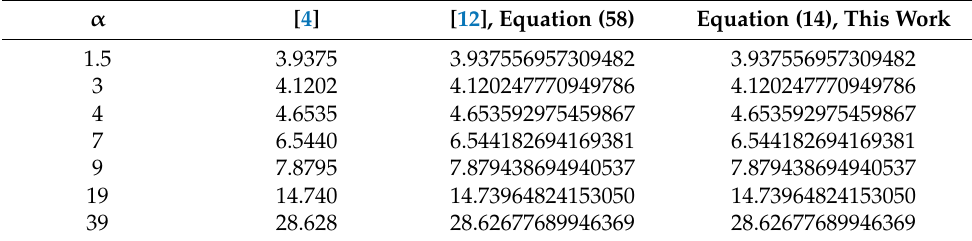
Table 2. Self-inductance given as L N = L / N 2 / R 1 in µ H/m.